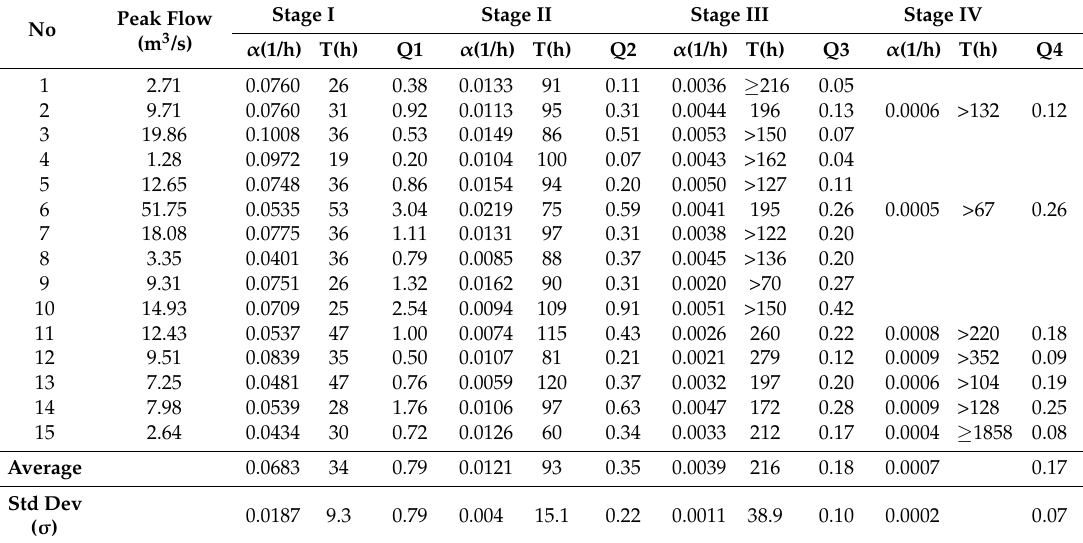
Table 2. Table of recession coefficients and recession stages at Miaogou Karst